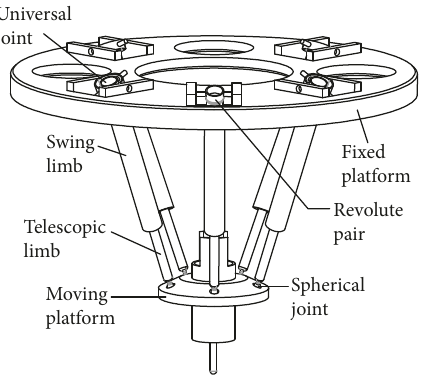
Figure 1: 4-UPS-RPS parallel mechanism.